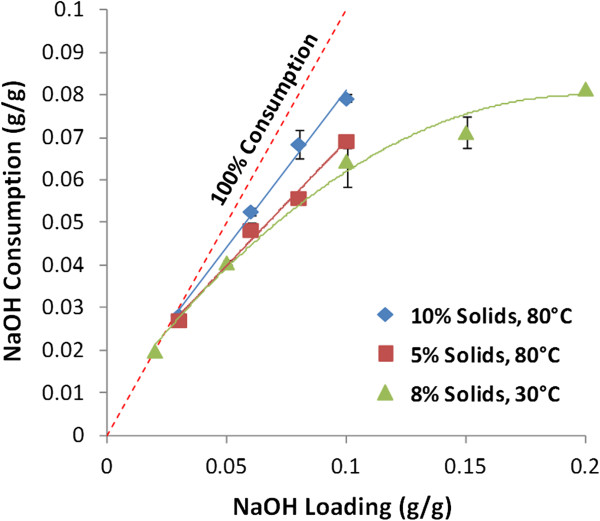
Alkali consumption during alkaline pre-extraction of corn stover as a function of solids concentration (w/v), NaOH loading, and temperature. The alkali consumption is shown to approach a horizontal asymptote at between 0.08 and 0.10 g/g NaOH loading.